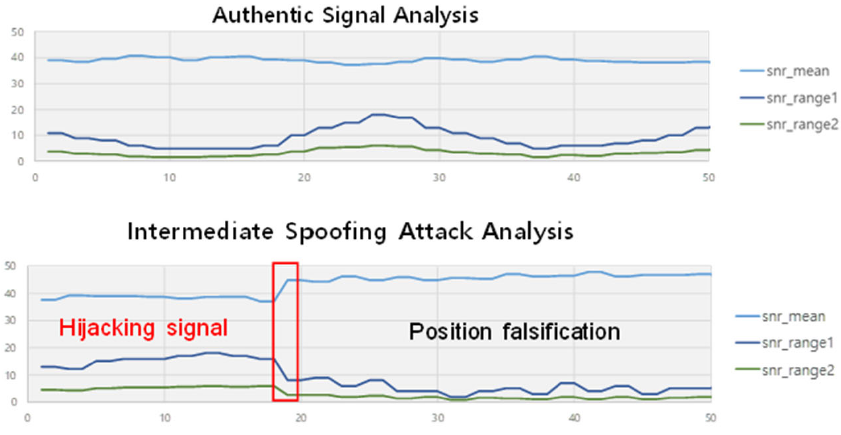
Figure 7. Spoofing data analysis.